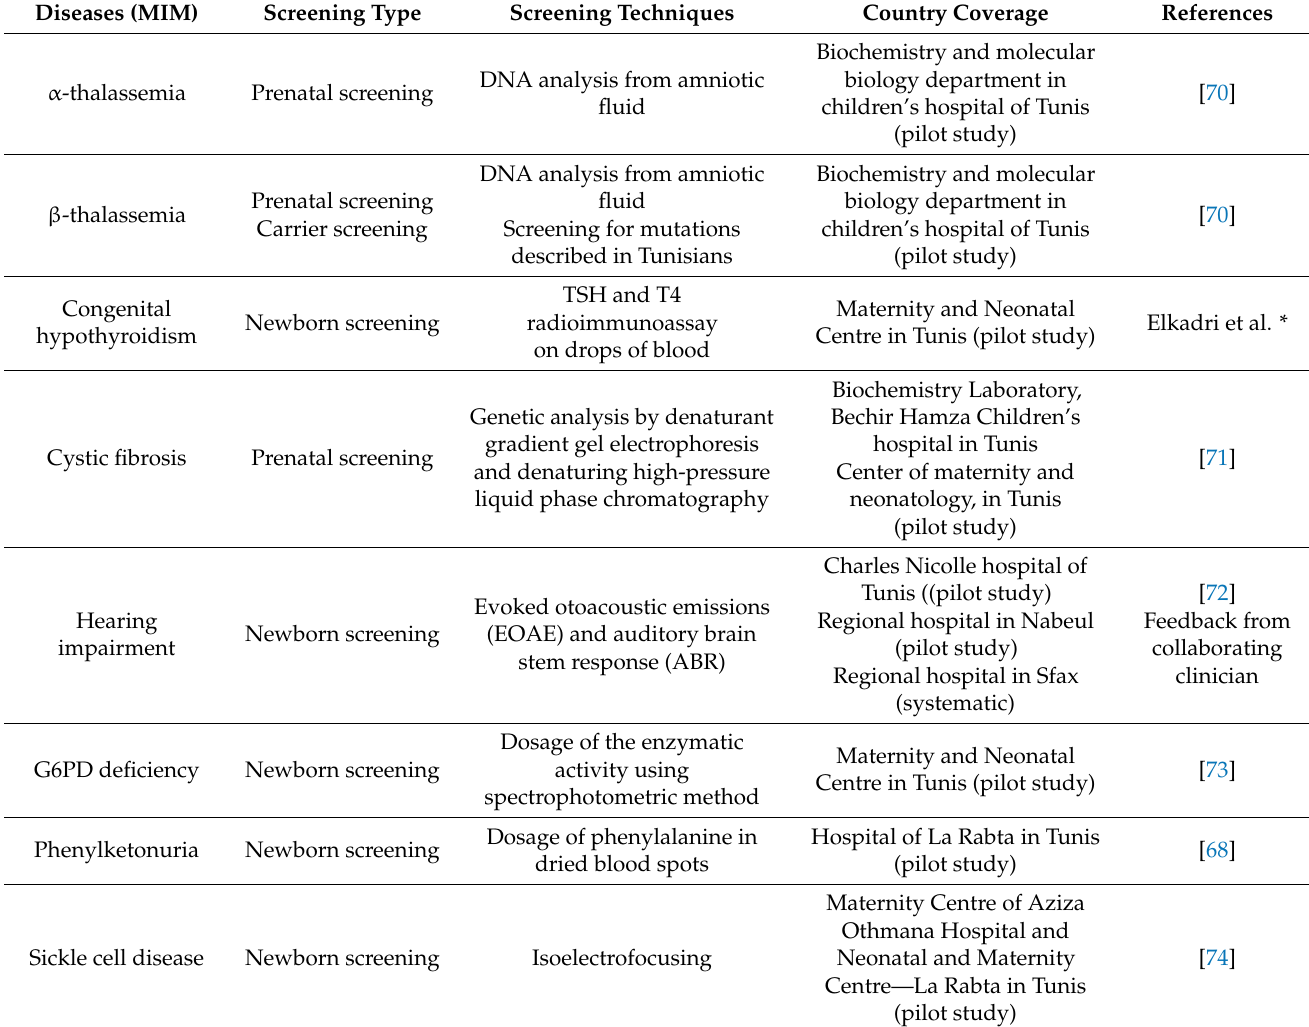
Table 5. Screening of genetic diseases in